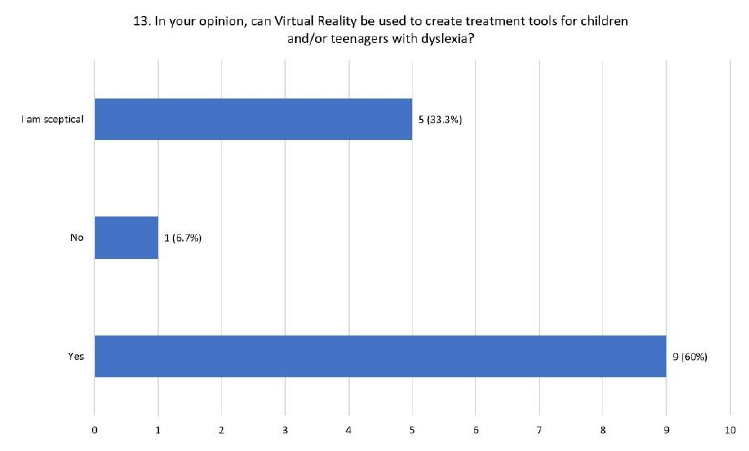
Figure 5. Distribution of responses to question 8 ( a ) and question 9 ( b ).